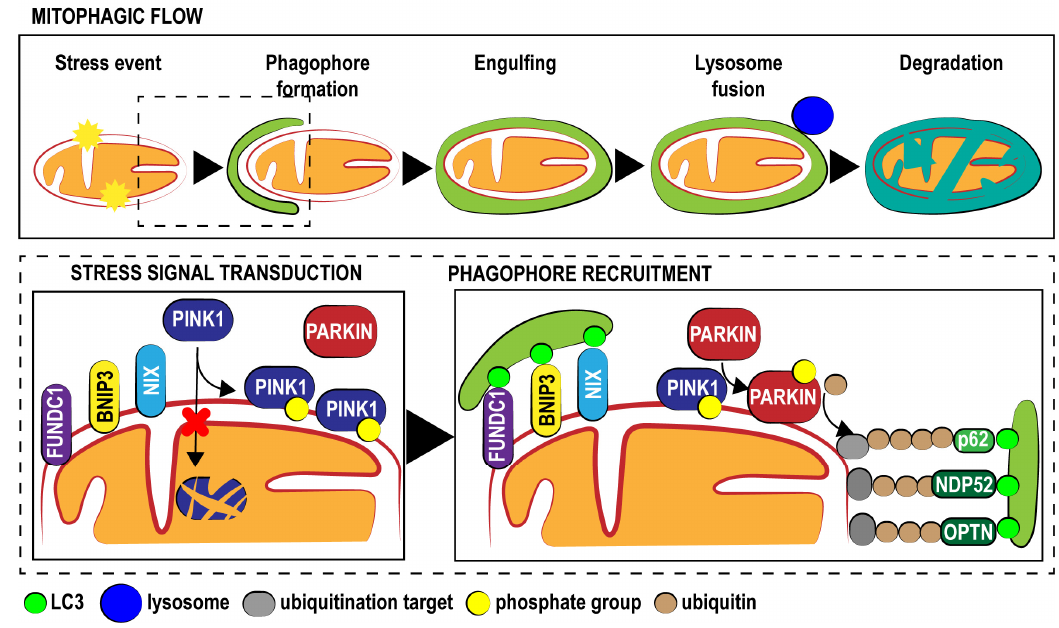
Figure 1. Molecular routes of mitophagy. Schematic representation of mitochondrial fate during mitophagy (upper panel). Representation of rearrangements of effectors onto the OMM in response to stress stimuli (lower left panel) and participants in the recruitment of the phogophore around the OMM (lower right panel) during mitophagy. OMM, outer mitochondrial membrane; FUNDC1, FUN14 Domain Containing 1; BNIP3, BCL2/adenovirus E1B 19 kDa protein-interacting protein 3; NIX, NIP-3-Like Protein X; PINK1, PTEN-induced kinase 1; PARKIN, Parkin RBR E3 Ubiquitin Protein Ligase; NDP52, Nuclear Domain 10 Protein 52; OPTN, Optineurin; LC3, Microtubule Associated Protein 1 Light Chain 3.